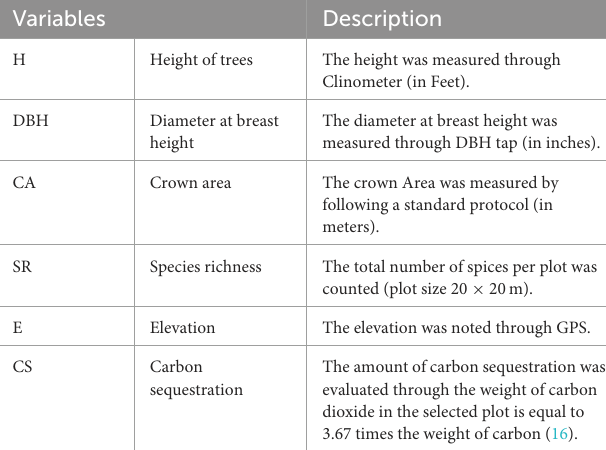
TABLE 2 Description of the independent and dependent variables. Variables